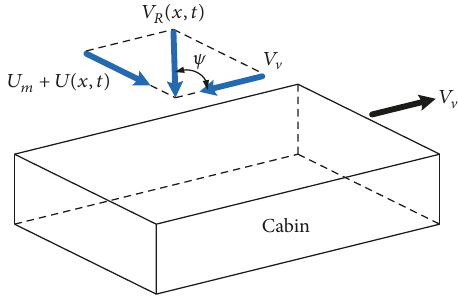
Figure 5: Wind loads on the maglev